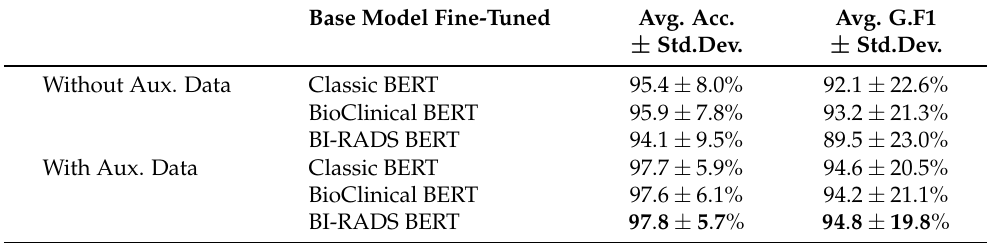
Table 2. Results of 5-fold cross validation section segmentation, evaluated with average accuracy with standard deviation (Std.Dev.) and average G.F1 with standard deviation (Std.Dev.) across all 900 reports used for fine-tuning. Aux. Data = the classification of the previous sentence in the report, the number of the given sentence it is classifying, and the total number of sentences in the report. Base Model Fine-Tuned Avg. Acc. Avg. G.F1 ± Std.Dev. ± Std.Dev. Without Aux. Data Classic BERT 95.4 ± 8.0% 92.1 ± 22.6% BioClinical BERT 95.9 ± 7.8% 93.2 ± 21.3% BI-RADS BERT 94.1 ± 9.5% 89.5 ± 23.0% With Aux. Data Classic BERT 97.7 ± 5.9% BioClinical